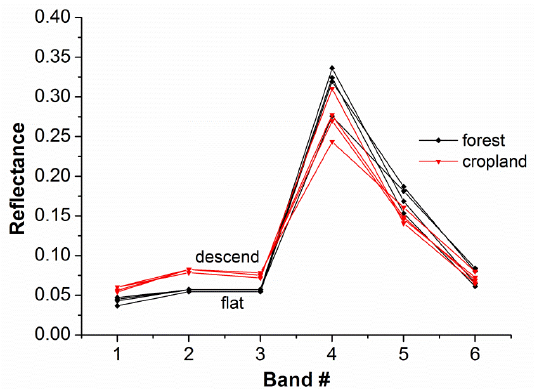
Figure 2. Spectral curves of the cropland (red line) and forest (black line) classes, from remotely sensed data.